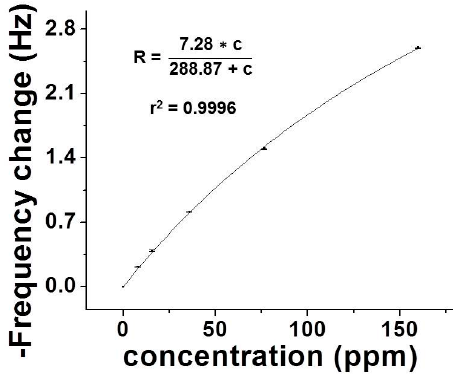
Figure 2. Sensor calibration under different concentrations of o -xylene.